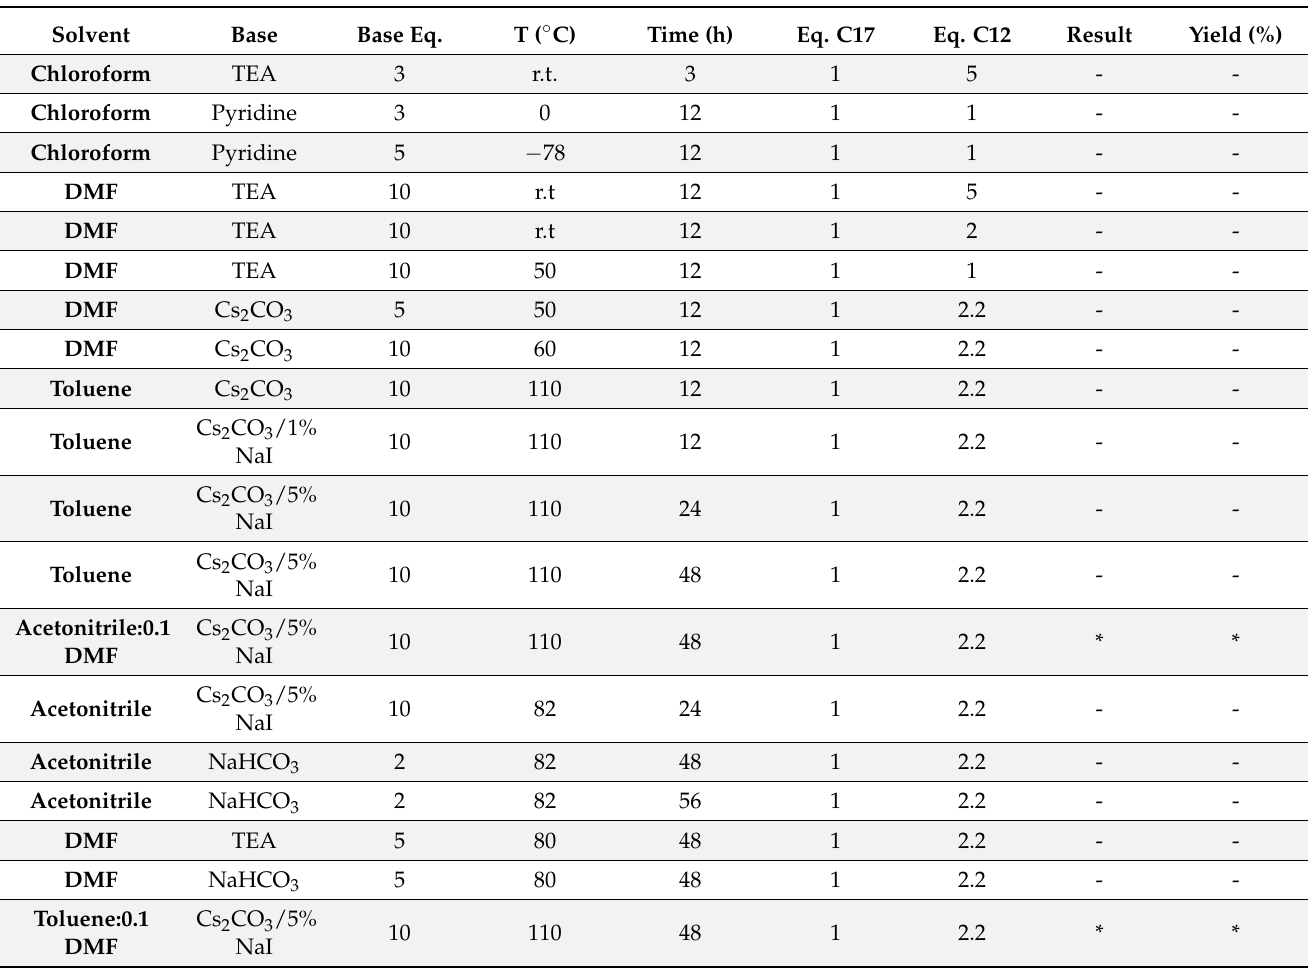
Table 1. Every single reaction was performed in duplicate, purified by flash column chro- matography (FCC) and preparative TLC using as eluents DCM (90%):MeOH (9.9%):TEA (0.1%) for starting materials and toluene (30%):hexane (69.9%):TEA (0.1%) for the expected product, resulting in minimal amounts of product, enough for the 1 H–NMR and MS studies. Table 1. The reaction between compounds 12 and 17 is a possible way to reach